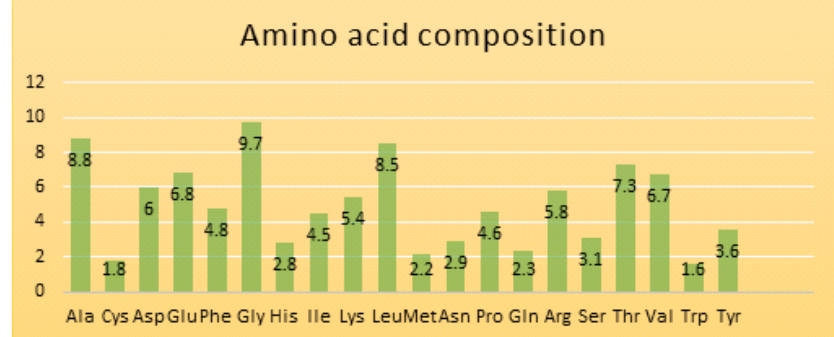
Fig. 1. The average amino acid composition of RuBisCO proteins from Carthamus